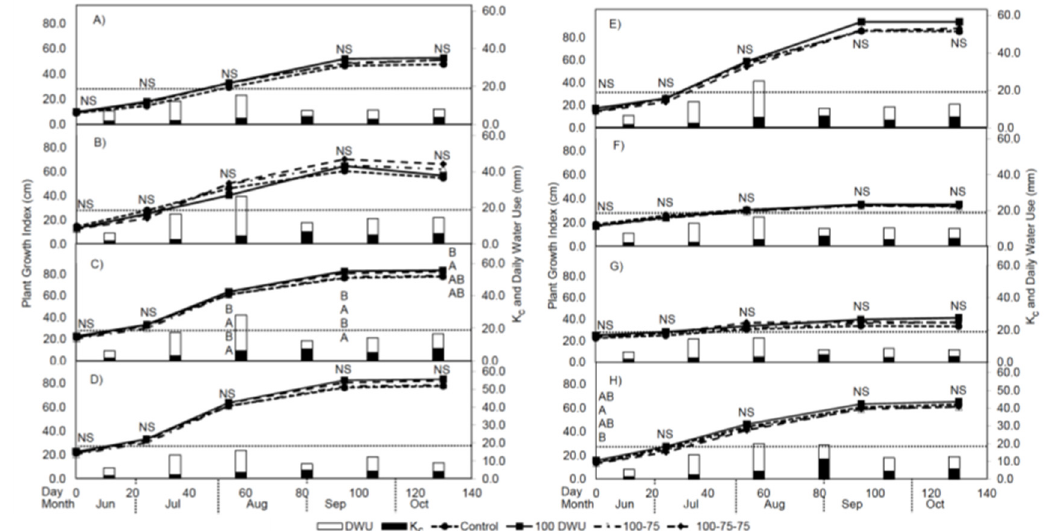
Figure 3. Plant Growth Index (GI), Daily Crop Coefficient (K C ), and Daily Water Use (DWU) from 10 June (Day 0) to 14 October 2009 (Day 126) for ( A ) Aronia arbutifolia ‘Brilliantissima’, ( B ) Cornus sericea ‘Farrow’, ( C ) Hydrangea paniculata ‘Limelight’, ( D ) Itea virginica ‘Morton’, ( E ) Physocarpus opulifolius ‘Seward’, ( F ) Spiraea media ‘Darsnorm’, ( G ) Thuja plicata ‘Grovepli’, and ( H ) Weigela florida ‘Alexandra’ grown in 10 .2 L containers. Left y-axis indicates PGI (lines). Control = 19 mm · application − 1 ; 100DWU = 100% daily water use (DWU) replacement each day; 100-75DWU = 2-day cycle alternating 100% DWU and 75% DWU; and 100-75-75DWU = 3 day cycle with 100% DWU replacement the first day then 2 days 75% DWU replacement. Each day was analyzed separately (Tukey’s test, α = 0.05, n = 18). Means followed by the same letters are not different. NS = not significant. Right y -axis indicates DWU where the entire bars represent DWU (mm) averaged from all treatments ( n = 72); shaded portions of bars represent daily K C (DWU: ET 0 , n = 72). Overhead irrigation scheduling based on lowest DWU of the 8 taxa during each measurement period; remaining water requirement supplied by hand each day as necessary. y Different letters denote significant differences between treatments in order from top to bottom: Control, 100DWU, 100-75DWU, 100-75-75DWU with A associated with the greatest mean value and subsequent letters associated with lower mean values. In both 2009 and 2010, plant GI steadily increased in June and July, slowed between August and September, and reached a plateau in September to October as new growth began hardening in preparation for winter (Figures 3 and 4). There were no differences in GI in 2009 except for H. paniculata ‘Limelight’ where control was smaller than 100DWU from day 42 on and smaller than 100- 75-75DWU on days 42 and 74, however, these differences were fairly small (Figure 3). No growth differences were observed on any measurement date throughout 2010 except the final date where H. paniculata ‘Limelight’ had smaller GI for 100-75-75DWU than other treatments, again the differences were minor (Figure 4). There were no differences in shoot dry weight for the three taxa evaluated in 2010 (data not shown).